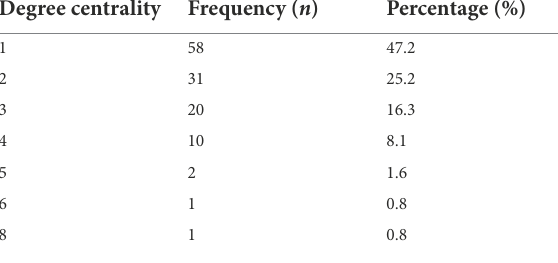
TABLE 2 The distribution of degree